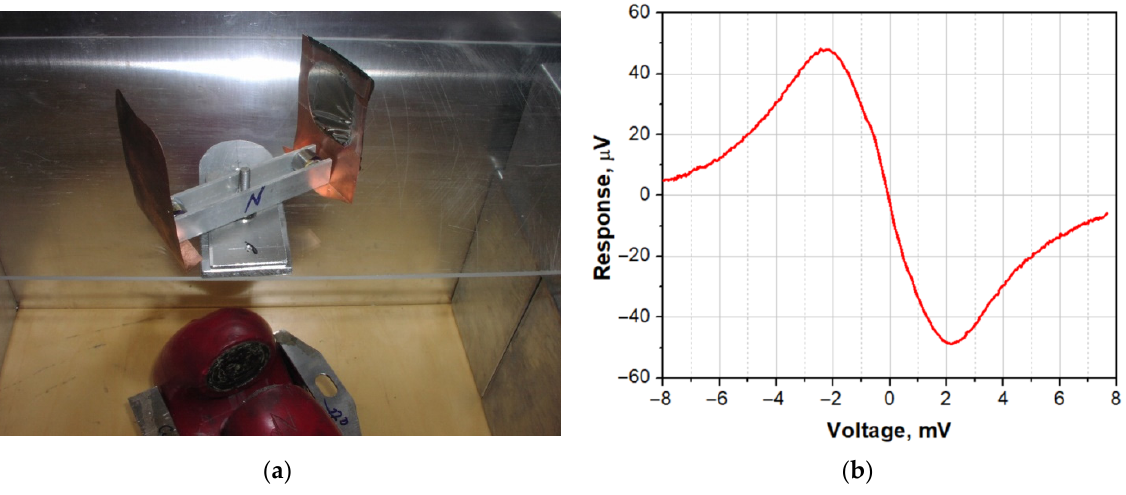
Figure 6. ( a ) Room-temperature demonstration model of rotating cryogenic absorber and reflector and ( b ) measured voltage response of SINIS detector to switching of aperture from reflector to thin film 10 dB absorber made on Kapton.